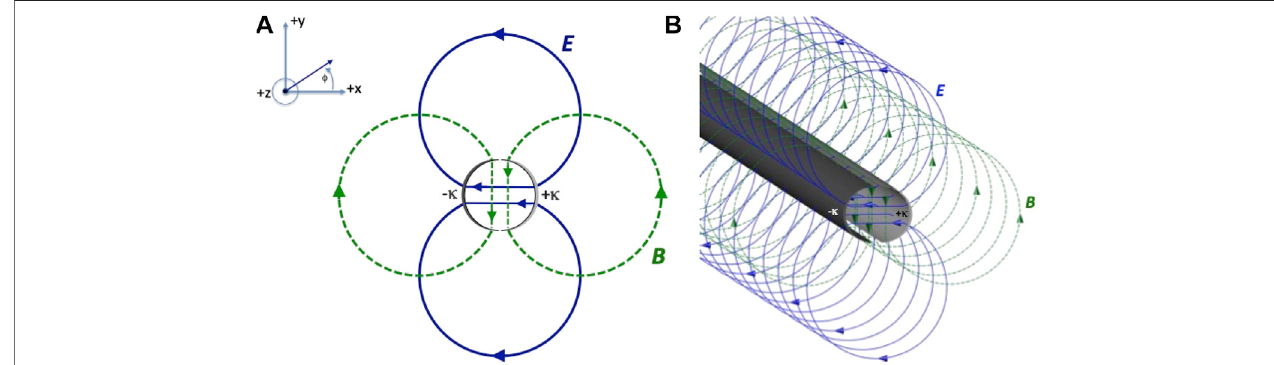
FIGURE 1 | (A) A plot of Eq. 4 that illustrates a transverse section of the fi elds. The center ring represents the waveguide, and the right and left semicircular arcs represent, respectively, layers of positive and negative polarization charges described by Eq. 5 . Solid lines represent electric fl ux, and dotted lines represent magnetic fl ux.Theinterior fl uxlinesarestraightandintercepttheguidewallatangle ϕ – π /2 < ϕ < π /2.Theexterior fl uxlinesarecircular,centeredat y (cid:2) csc( ϕ 0 ,where 0 0 )/2,normalto the guide wall and, if continued through it, would pass through the axis. All electric fl ux lines stop and start on polarization charges and all magnetic fl ux lines surround z -directed effective polarization currents (not shown). (B) A plot of the same equation showing an extended length of